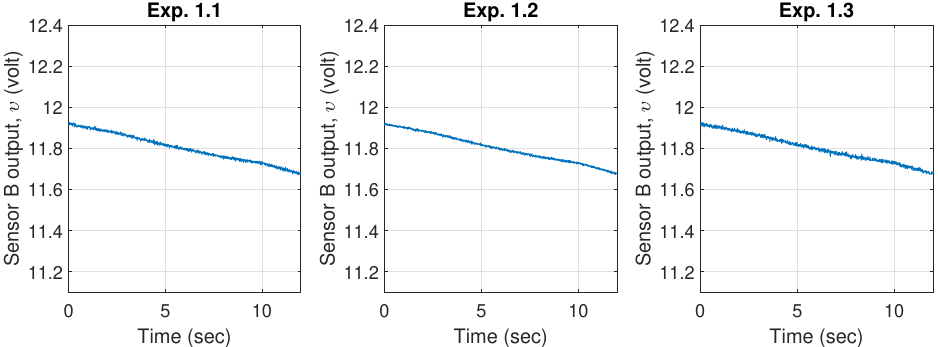
Figure 12. Measured power supply from Sensor B output for each experiment (for validation purposes).